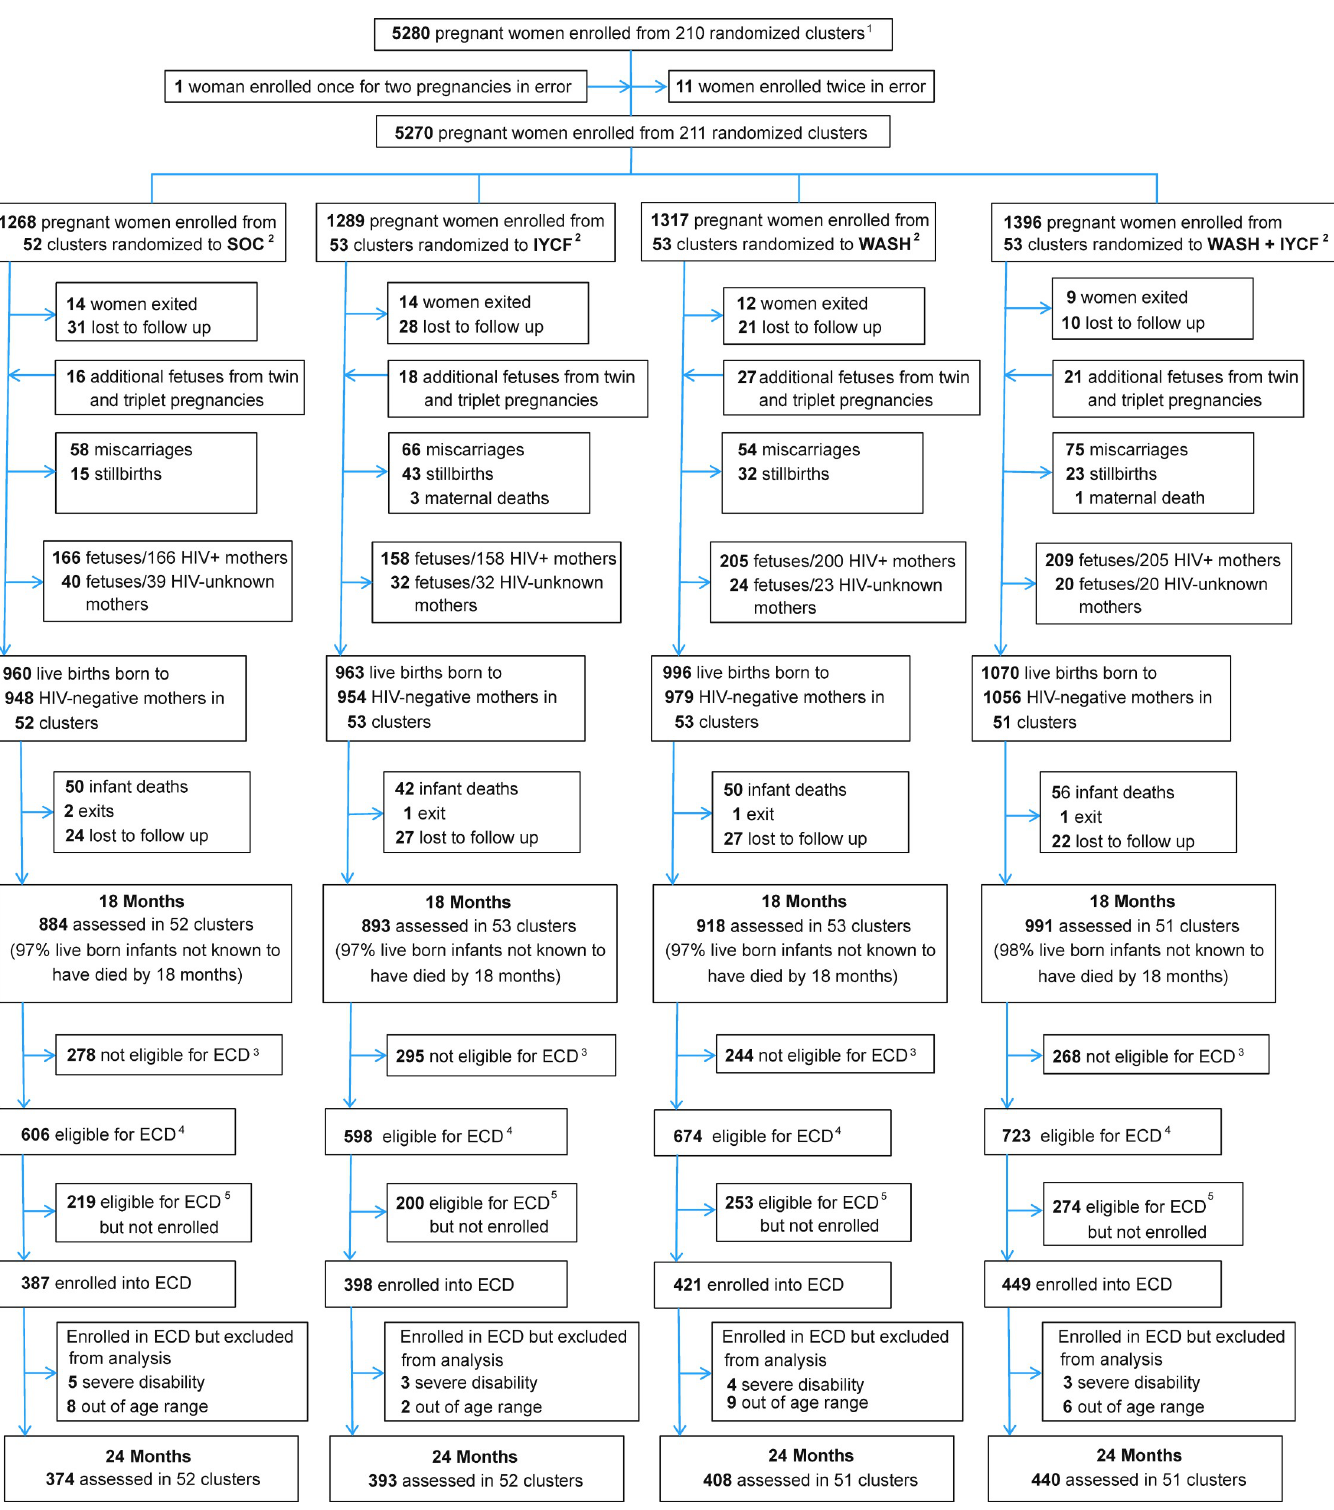
Fig 1. Flow of participants through the SHINE early child development (ECD) substudy. 1 In all, 212 clusters were randomized, 53 in each of the 4 trial arms. After randomization, 1 cluster was excluded as it was determined to be in an urban area, 1 cluster was excluded as the village health worker covering it mainly had clients outside the study area, and 1 more was merged into a neighboring cluster based on subsequent data on village health worker coverage. Three new cluster designations were